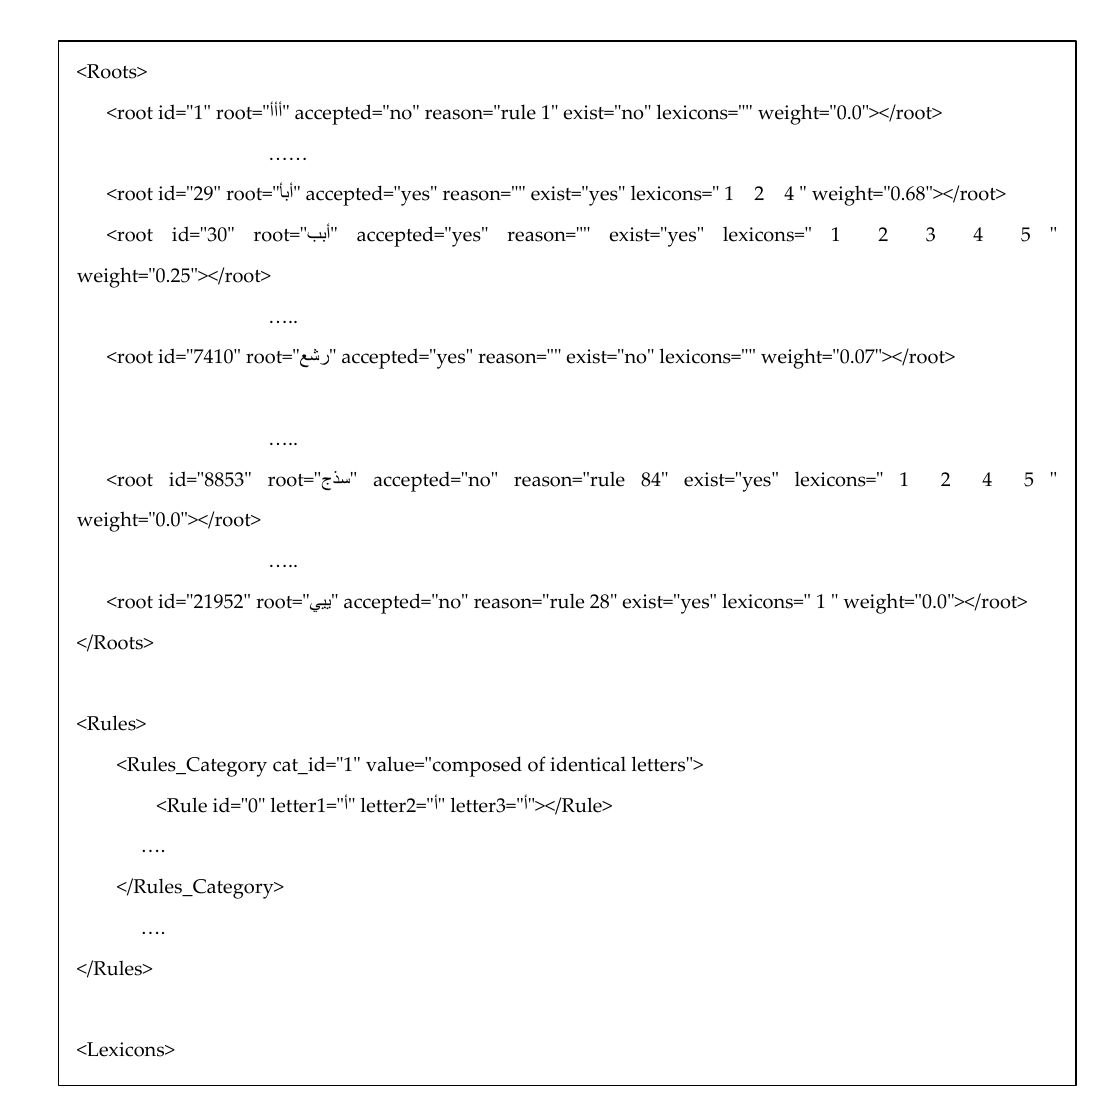
Figure 5. Structure and content sample of the proposed lexicon.